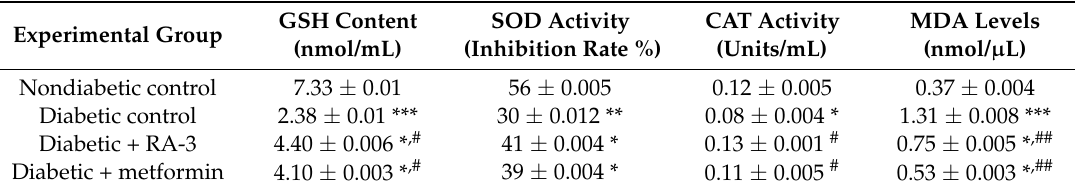
Figure 2. Oral glucose tolerance tests ( A ) and area under the curve (AUC) ( B ) in high fat diet and streptozotocin-induced type 2 diabetic rats treated with RA-3 and metformin (positive control). The untreated diabetic group presented with a significant increase in fasting plasma glucose levels (*** p ≤ 0.0001) compared to the non-diabetic rats and diabetic rats treated with RA-3 and metformin. ### p ≤ 0.001 vs. diabetic control. Results are expressed as the mean ± SEM and each treatment group contained at least five rats. One way analysis of variance (ANOVA), followed by a Tukey post-hoc test (Graph Pad Prism version 5.03) were used to determine statistical differences. The values were considered statistically significant where p ≤ 0.05. Table 2. The effect of RA-3 on lipid peroxidation and antioxidant levels after the 28 days treatment of the high fat diet and streptozotocin-induced type 2 diabetic rats.